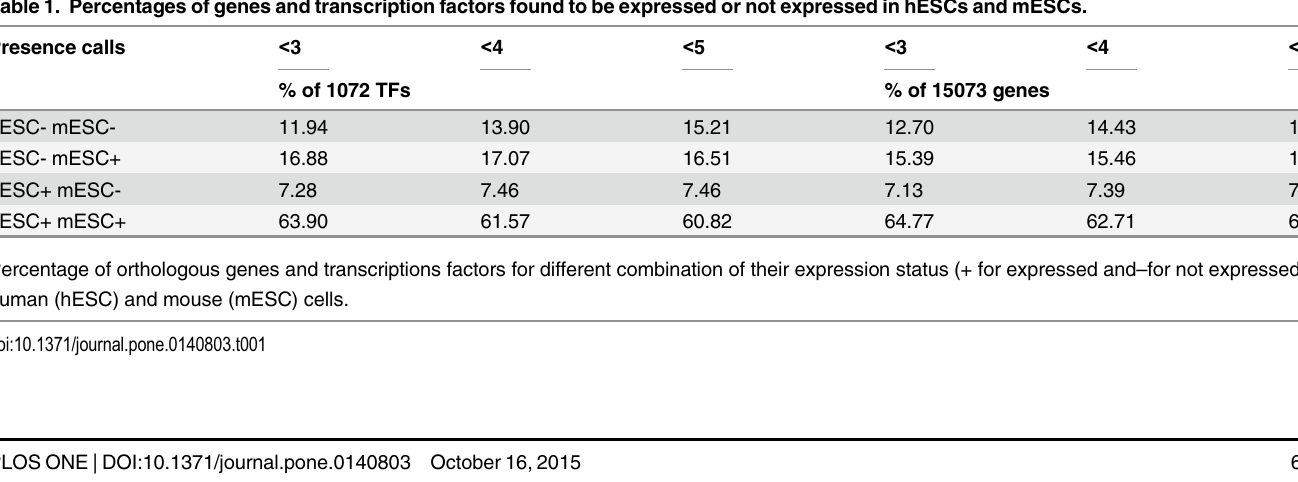
Table 1. Percentages of genes and transcription factors found to be expressed or not expressed in hESCs and mESCs. Presence calls < 3 < 4